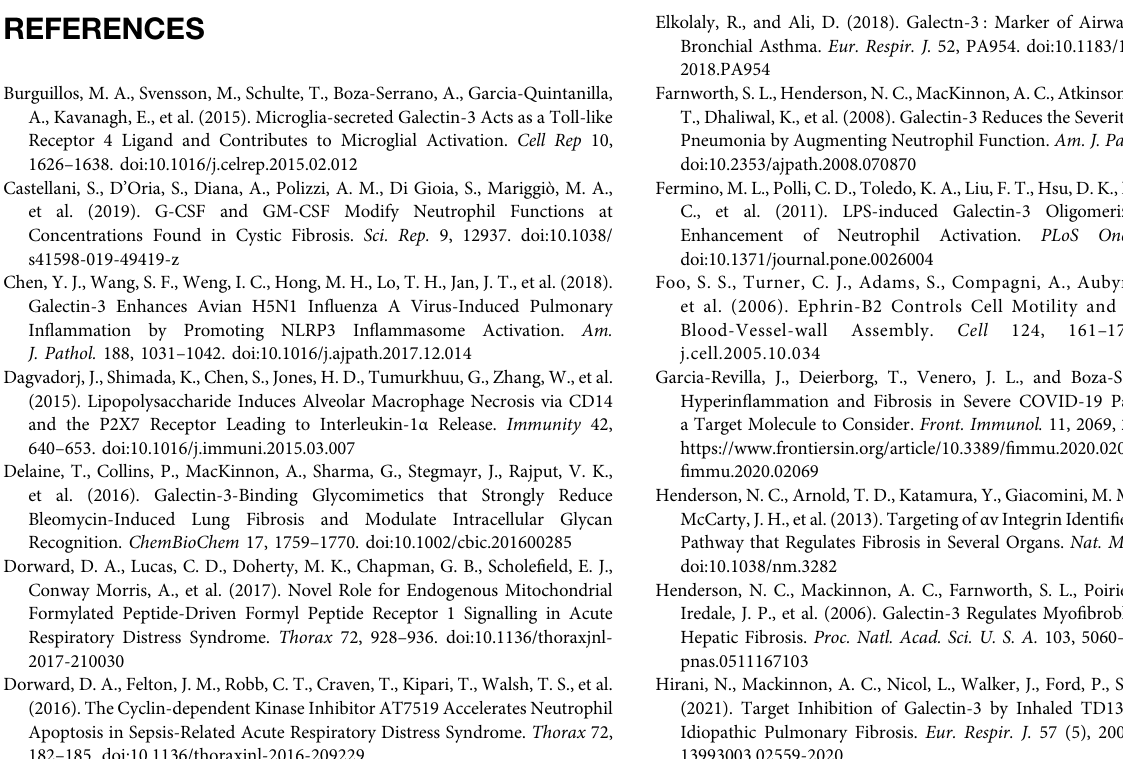
Supplementary Figure S3 | Gal-3immunohistochemistry/immuno fl uorescenceinLysM- cre and Pdgfrb-cre mice. (A) LysM-cre Gal-3 conditional knockdown in LPS-induced